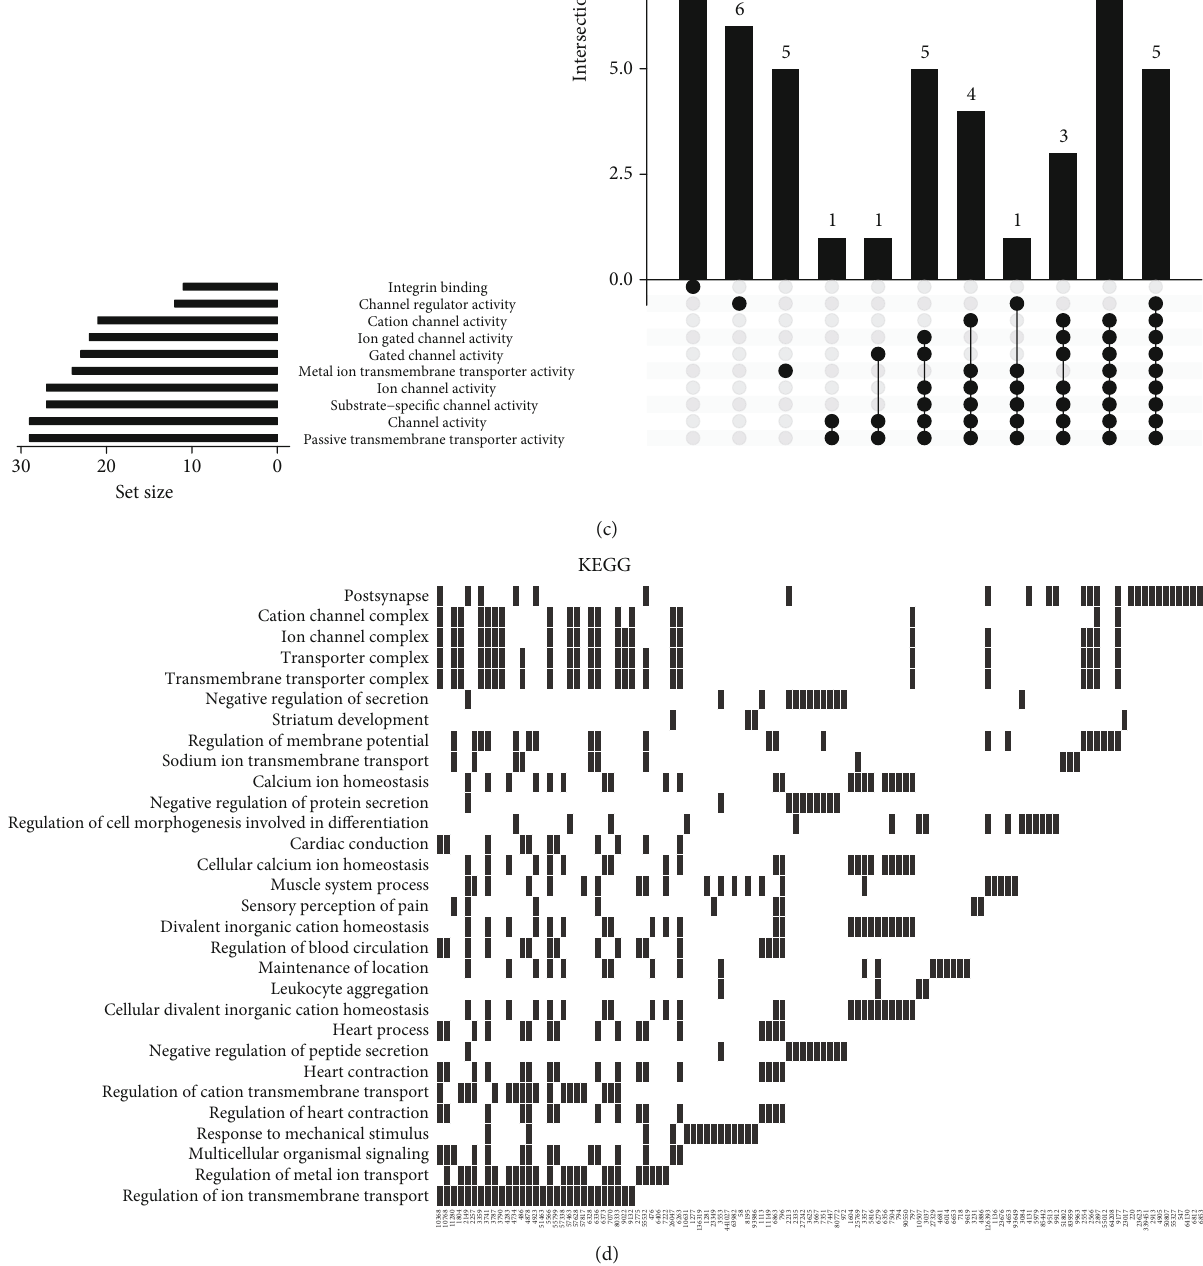
Figure 2: GO term and KEGG pathway enrichment analyses. (a) GO biological process, (b) GO cellular component, and (c) GO molecular function. (d) KEGG